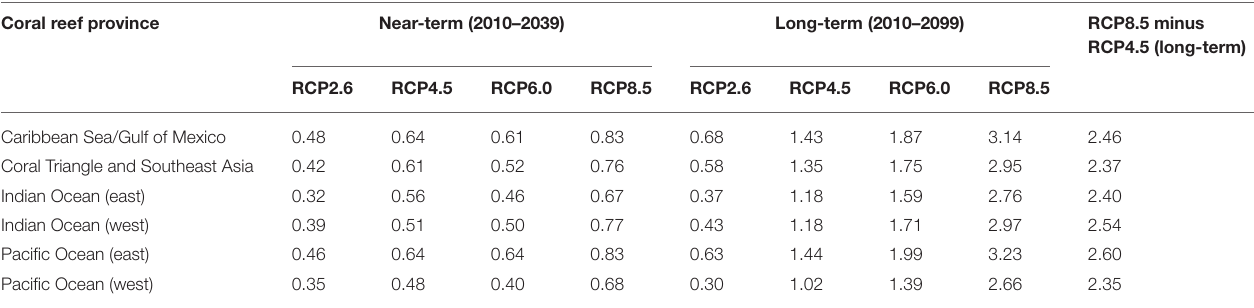
TABLE 2 | Projected changes in sea surface temperature (SST ◦ C) over the next 90 years for coral reef provinces (Figure 1B) from AOGCM model simulations from the Coupled Model Intercomparison Project Phase 5 (CMIP5,